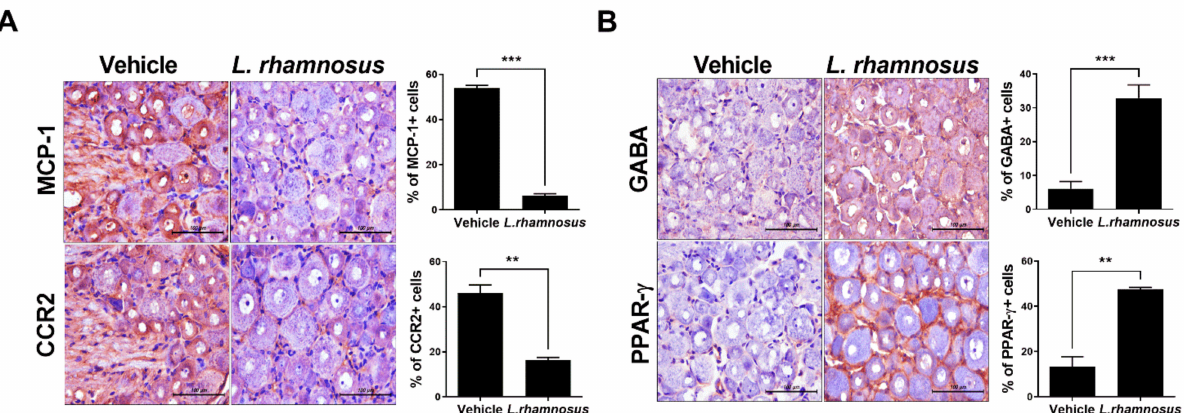
Figure 2. ( A , B ) Representative images of immunohistochemical staining for MCP-1, CCR2, GABA, and PPAR- γ in the DRG from vehicle-treated MIA-induced OA rats and L. rhamnosus (LR-2)-treated MIA-induced OA rats. Bar graphs show averaged percentages of MCP-1-, CCR2-, GABA-, and PPAR- γ -positive cells in the DRG. Data are presented as the mean ± SD of three independent experiments. ** p < 0.01 and *** p <